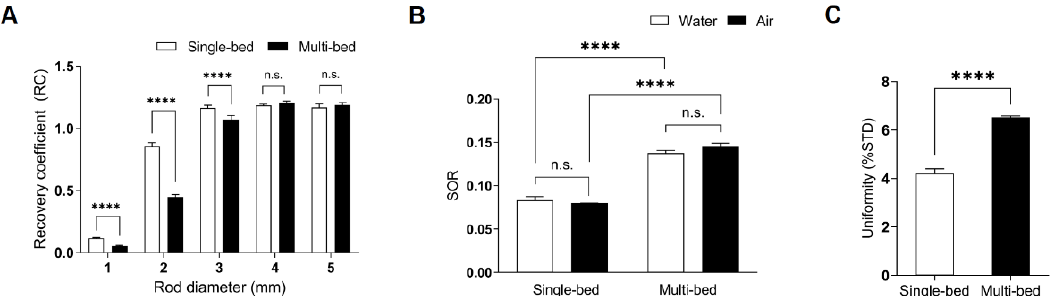
Figure 2. The RC values of 1–5 mm rods ( A ), spill-over ratios (SORs) ( B ), and uniformity values ( C ) of phantoms imaged in the single- and multi-bed systems. Statistical significance was defined as a p value less than 0.05 (**** p < 0.0001, n.s.= statistically nonsignificant difference).; %STD, percentage standard deviation.